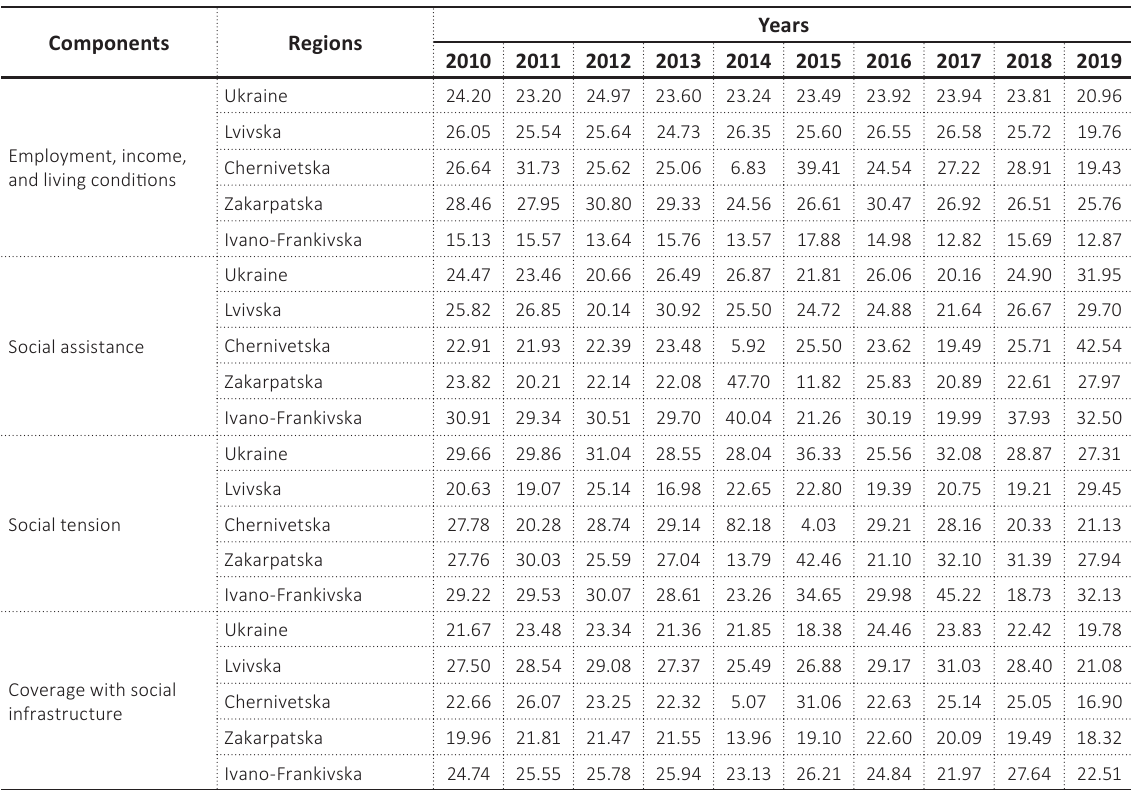
Table 3. Weight significance coefficients of the components of the population’s social resilience environment in the Carpathian region and Ukraine, 2010–2019, %